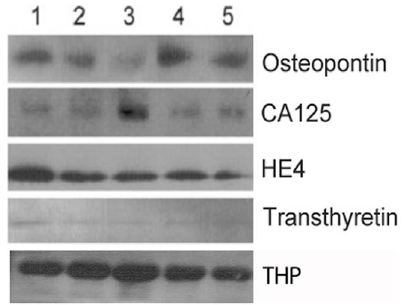
Figure 3. Western blot of OPN, CA 125, HE4, and TTR from human urine. A representative western blot of Osteopontin (OPN), CA125, HE4, and transthyretin (TTR) antigens expressed in protein lysates obtained from concentrated human urine samples from healthy individuals is depicted. Anti-Osteopontin, HE4, and TTR antibodies detected a single protein isoform of the corresponding proteins. Osteopontin migrated with an apparent molecular mass of 60 kDa, HE4 protein fragment migrated at 13 kDa, and TTR at 15 kDa. Anti-CA125 antibody detected three different protein fragments. The major CA125 fragment migrated in SDS-PAGE with an apparent molecular mass of 41 kDa (shown) and two smaller protein bands were in the range of , 28–30 kDa. The presence of the different CA125 protein fragments in the human urine samples was confirmed by immunoblotting using various anti-CA125 antibodies. THP (68 kDa band) was evaluated as a loading control.